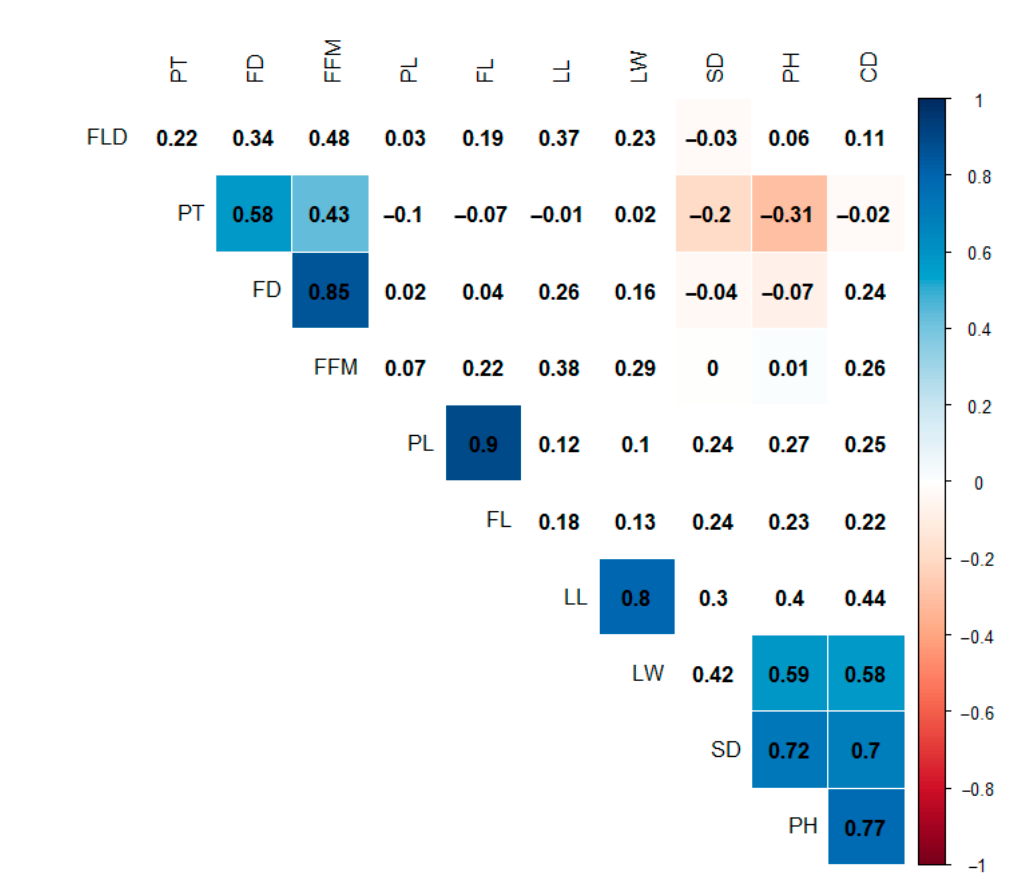
Figure 2. Pearson’s correlation between the 11 descriptors used to characterize 69 Capsicum accessions. Blue and red boxes indicate positive and negative correlation, respectively. The white boxes indicate no significant correlation ( p < 0.05). In the right side of the correlogram, the legend color shows the correlation coefficients and the corresponding colors. PH—plant height; CD—canopy diameter; SD—stem diameter; LL—leaf length; LW—leaf width; PL—petiole length; FL—fruit length; FD—fruit diameter; FFM—fruit fresh mass; PT—pericarp thickness; FLD—flower